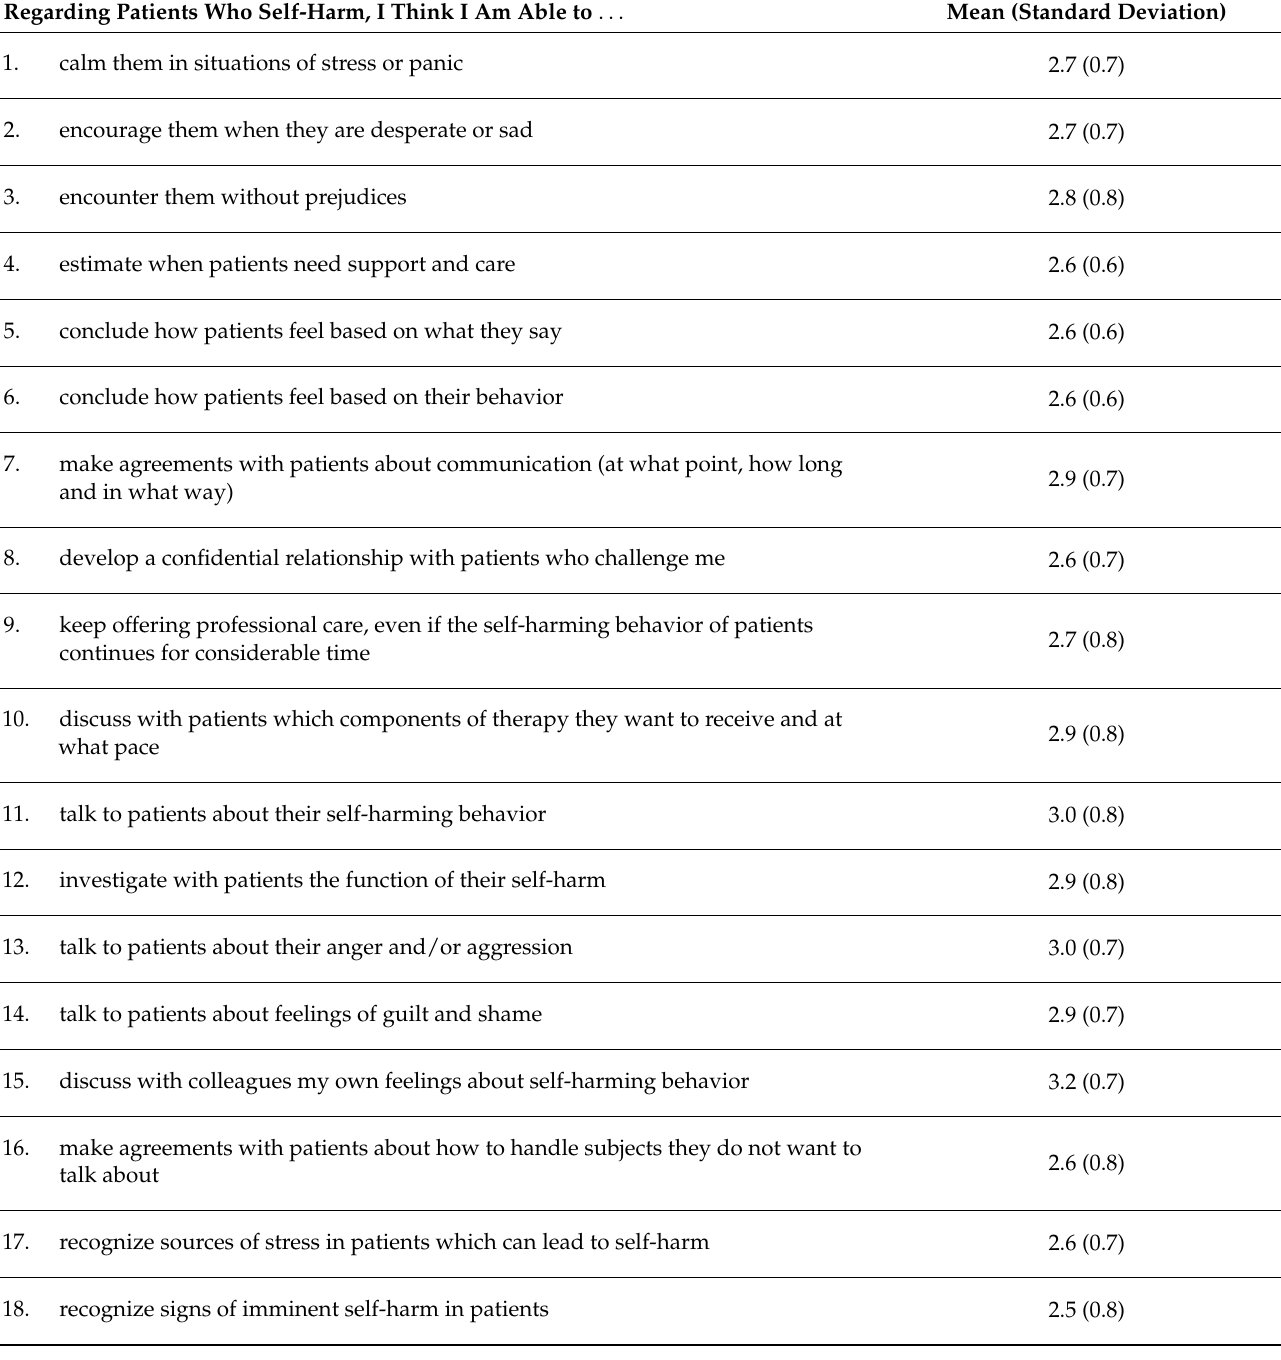
Table 1. Items of the Self-Efficacy in Dealing with Self-Harm Questionnaire (N =